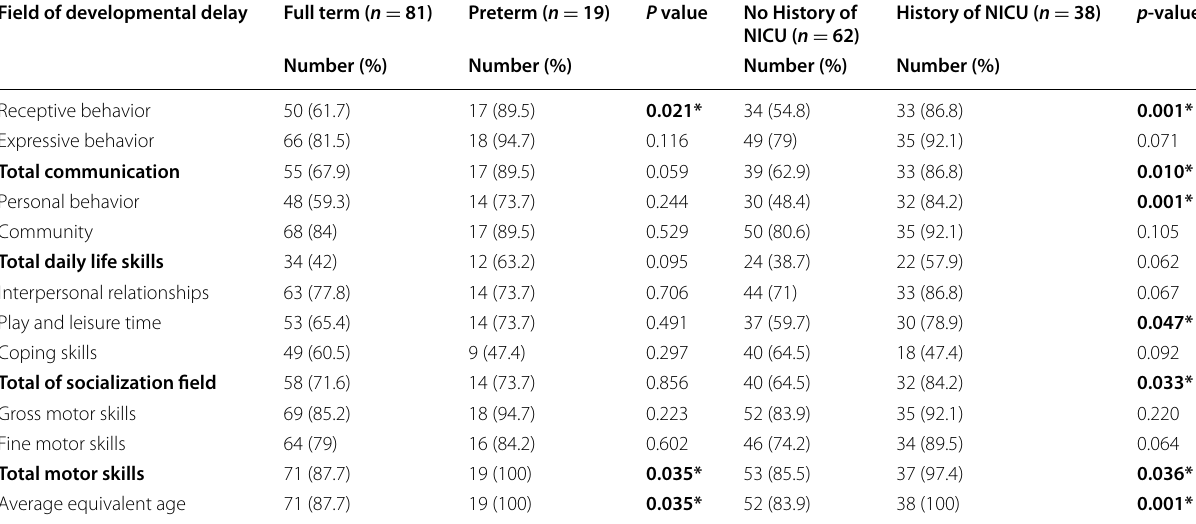
Table 2 Comparison between the presence of prematurity or history of NICU as regard results of VABS